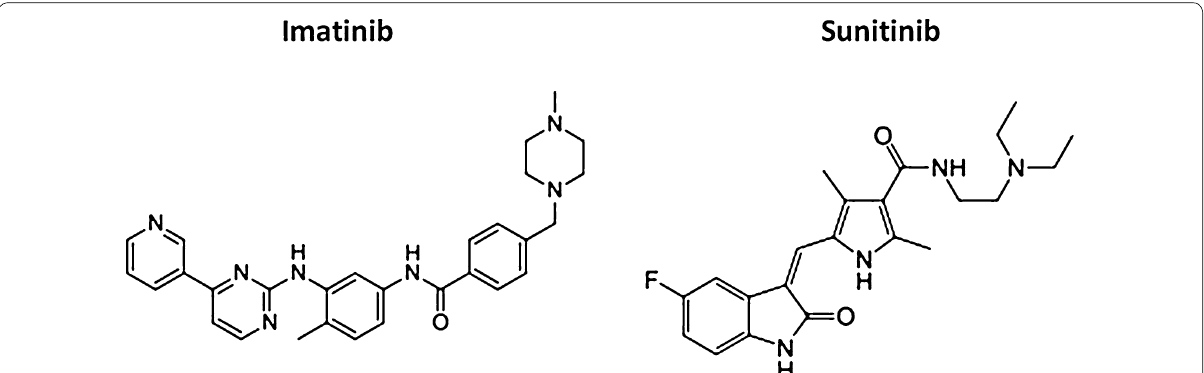
Fig. 3 Chemical structures of the tyrosine kinase inhibitors (TKIs) imatinib [Gleevec, approved by the Food and Drug Administration (FDA) of the United States in 2002 for the treatment of advanced GIST patients and marketed by Novartis] and sunitinib (Sutent, approved by the FDA in 2006 for the treatment of patients with imatinib-resistant GIST and marketed by